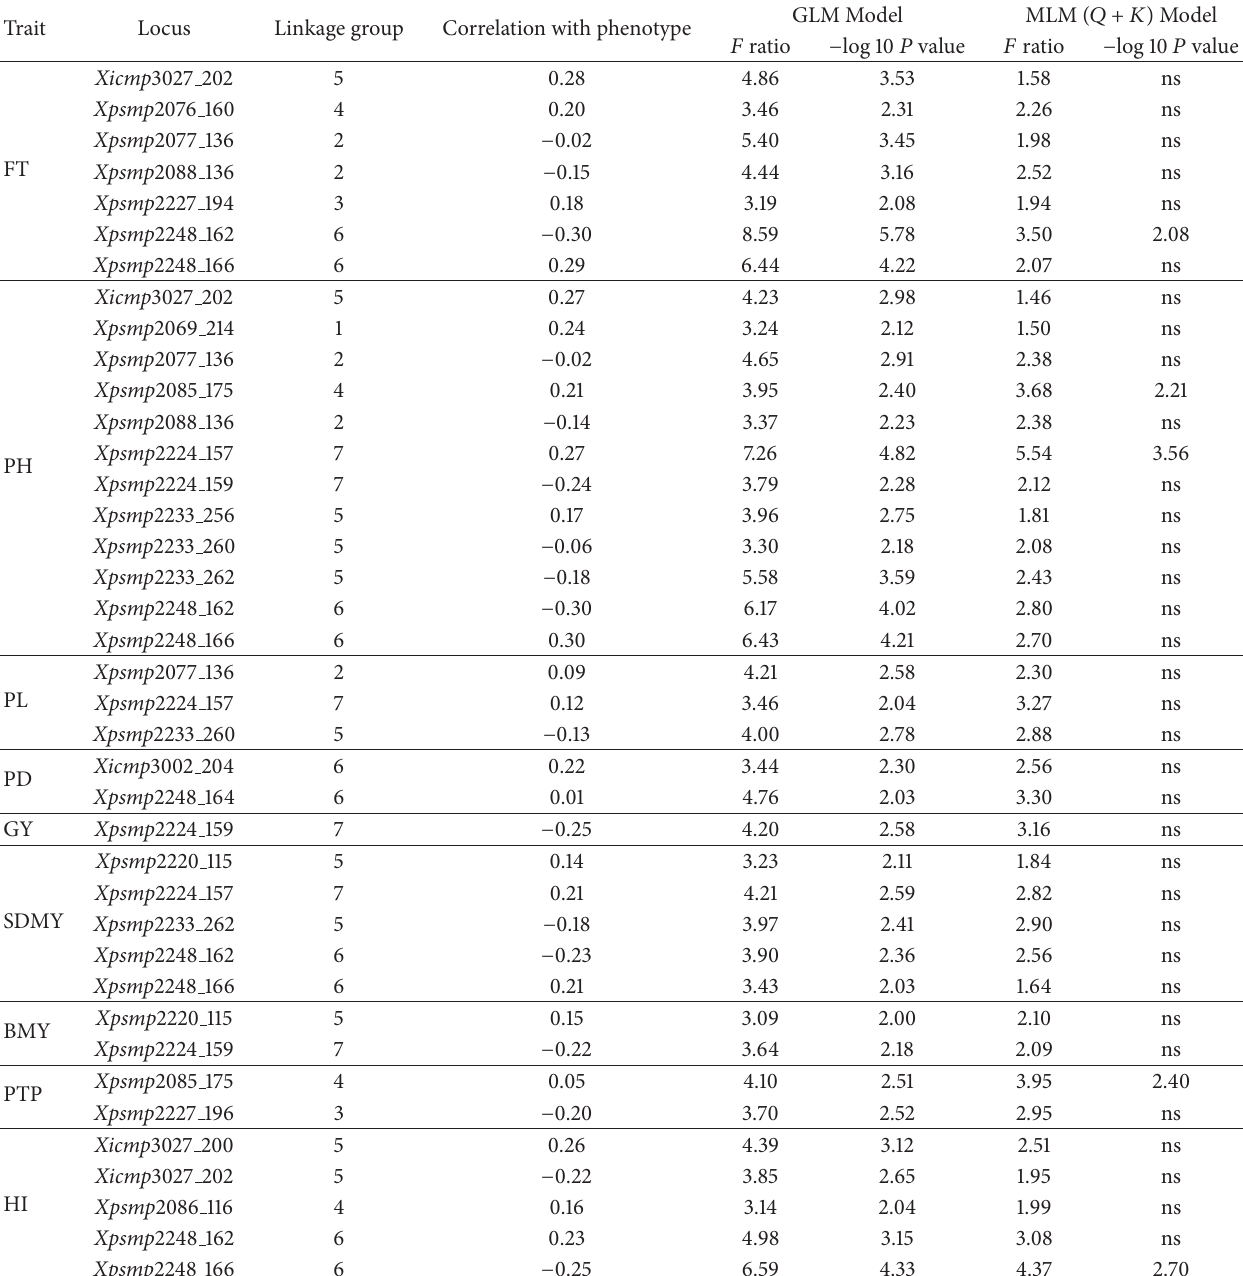
Table 4: Association of marker alleles with phenotypic traits using GLM and MLM ( 𝑄 + 𝐾 ) models and the across-season BLUPs. Trait